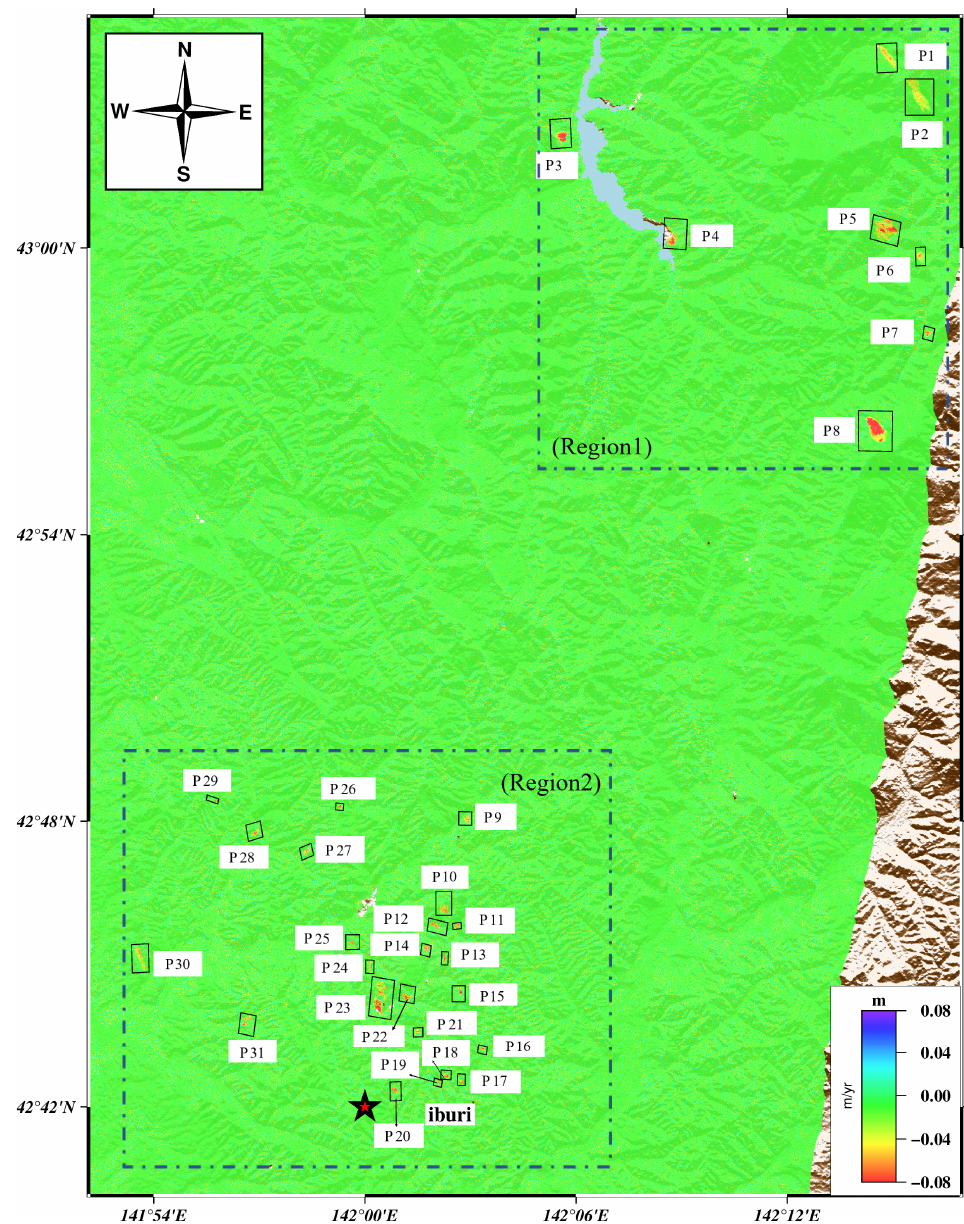
Figure 5. Distribution map of the monitored slow-moving landslides in the post-earthquake period. The average post-earthquake deformation velocity in the Iburi area is derived from the ALOS-2 PALSAR-2 data, and the black boxes indicate the locations of the slow-moving landslides. P1–P30 represent the slow-moving landslides detected in the post-earthquake period. Two typical regions of slow-moving landslides following the earthquake are shown by the blue box lines.